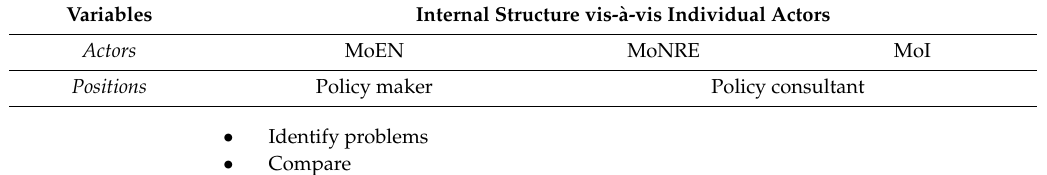
Table 5. Internal structure of policy development situation on the basis of